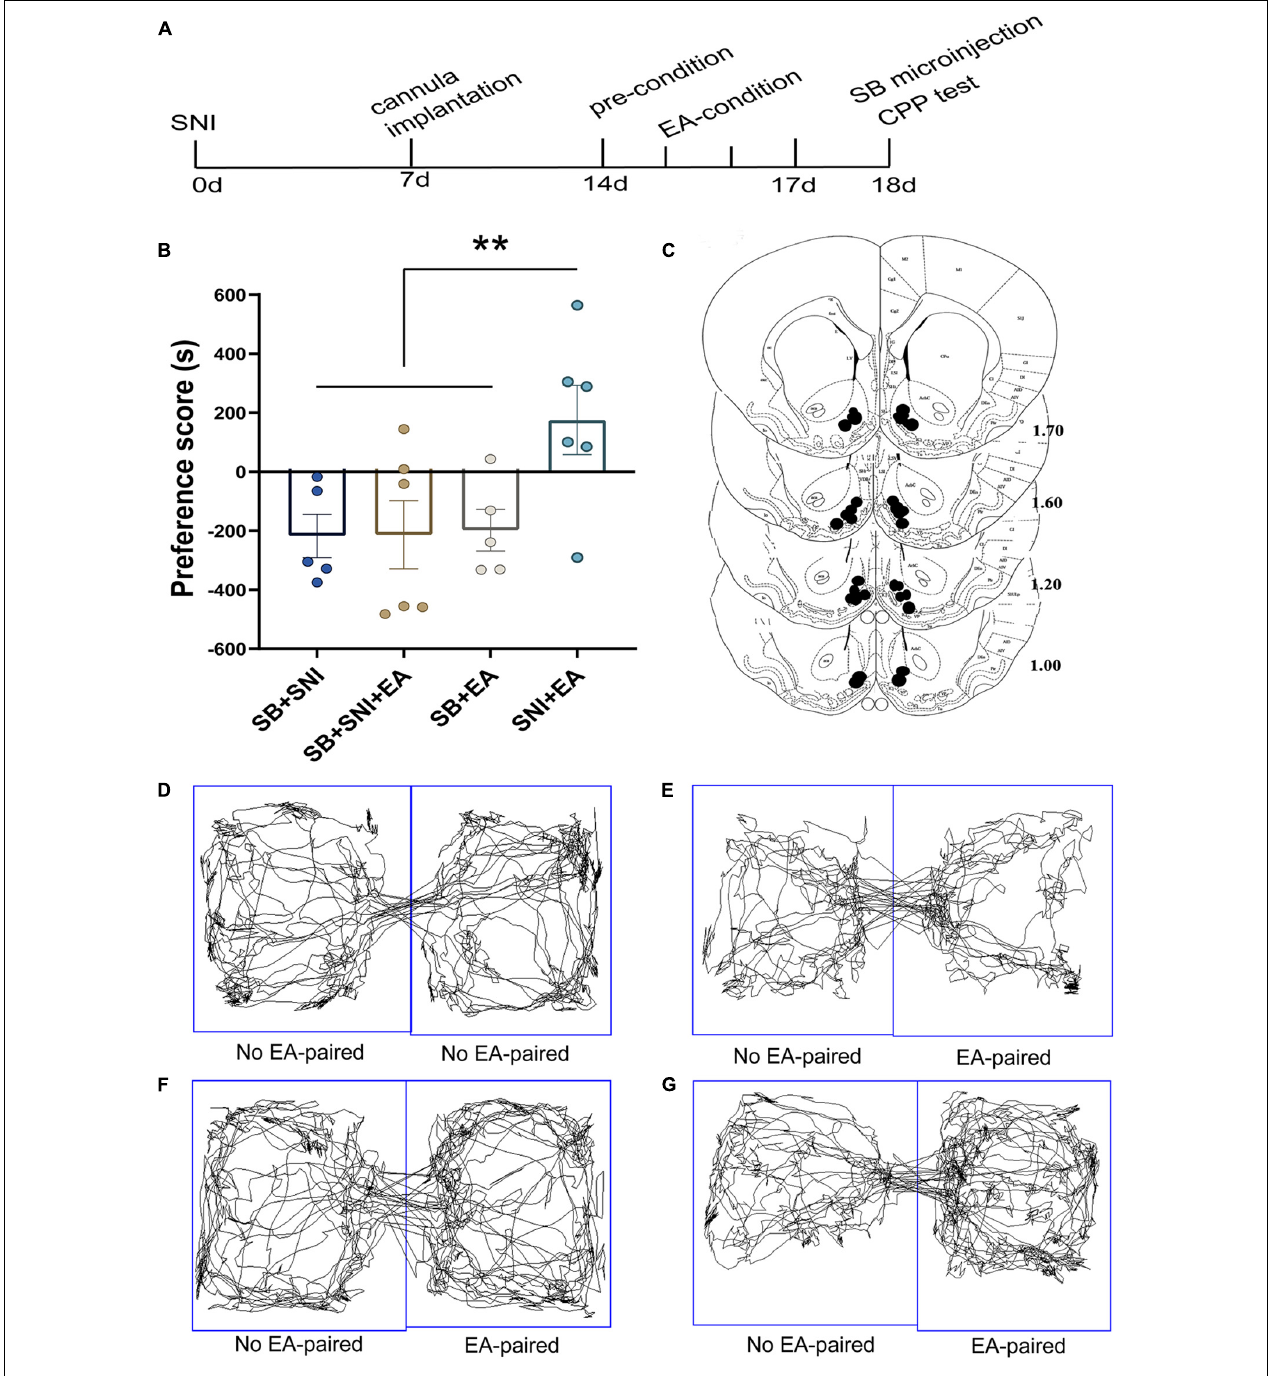
FIGURE 7 | Microinjection of orexin antagonist SB334867 into the NAc can markedly ablate EA induced CPP in SNI rats. (A) A timeline of SNI modeling, EA-induced CPP, SB microinjection and CPP test. (B) The preference scores after CPP testing among the various groups. ** p < 0.01 vs. SB + SNI group, SB + SNI + EA group and SB + EA group. (C) Microinfusion cannula placements. The numbers indicate distance from Bregma in millimeters. Real-time movement traces among the different groups during CPP test: (D) SB + SNI group; (E) SB + SNI + EA group; (F) SB + EA group; (G) SNI + EA group.